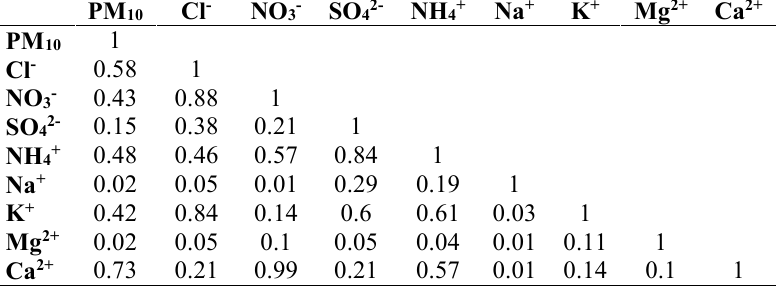
Table 4 Correlation coefficient of PM 10 and ions from burning of wood materials PM